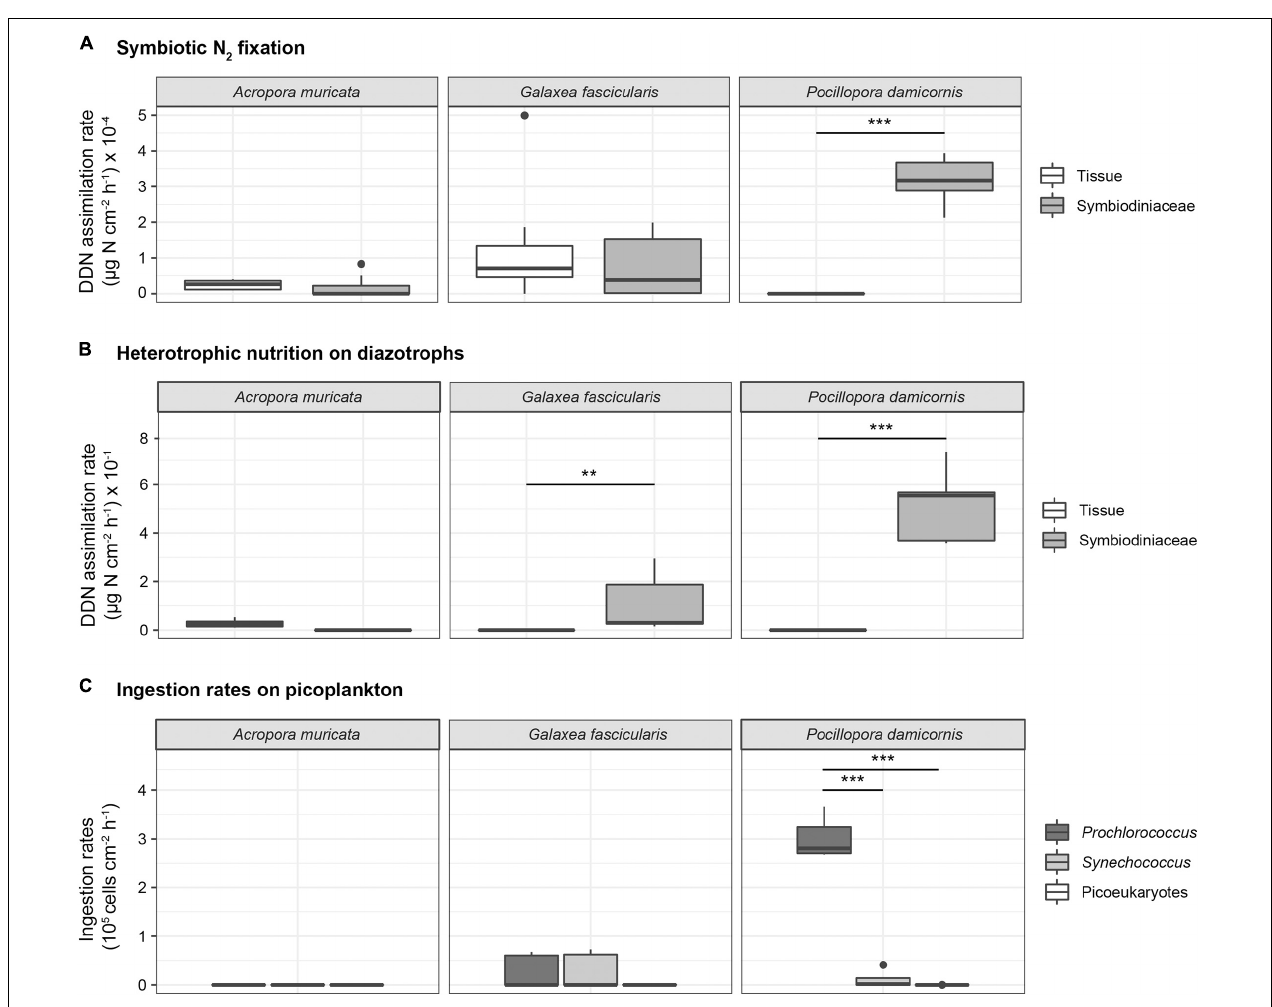
FIGURE 1 | (A) DDN assimilation rates ( µ g N cm – 2 h – 1 ) into coral tissue and Symbiodiniaceae fraction of A. muricata ( N = 10), G. fascicularis ( N = 10 and 8 for tissue and symbiont, respectively) and P. damicornis ( N = 10) after 8 h of exposure to 15 N 2 -enriched seawater. Horizontal line in each boxplot indicates the median and black dots represent the outlier sample. The asterisk indicates statistically significant differences (two-way ANOVA, *** p < 0.001). (B) DDN assimilation rates ( µ g N cm – 2 h – 1 ) into coral tissue and Symbiodiniaceae fraction of P. damicornis , A. muricata and G. fascicularis ( N = 5 for each species) after 8 h of exposure to 15 N 2 -enriched natural plankton assemblage ( N = 5 for each species). Horizontal line in each boxplot indicates the median and black dots represent the outlier sample. The asterisk indicates statistically significant differences (two-way ANOVA, *** p < 0.001, ** p < 0.01). (C) Ingestion rates (cell cm – 2 h – 1 ) of Prochlorococcus